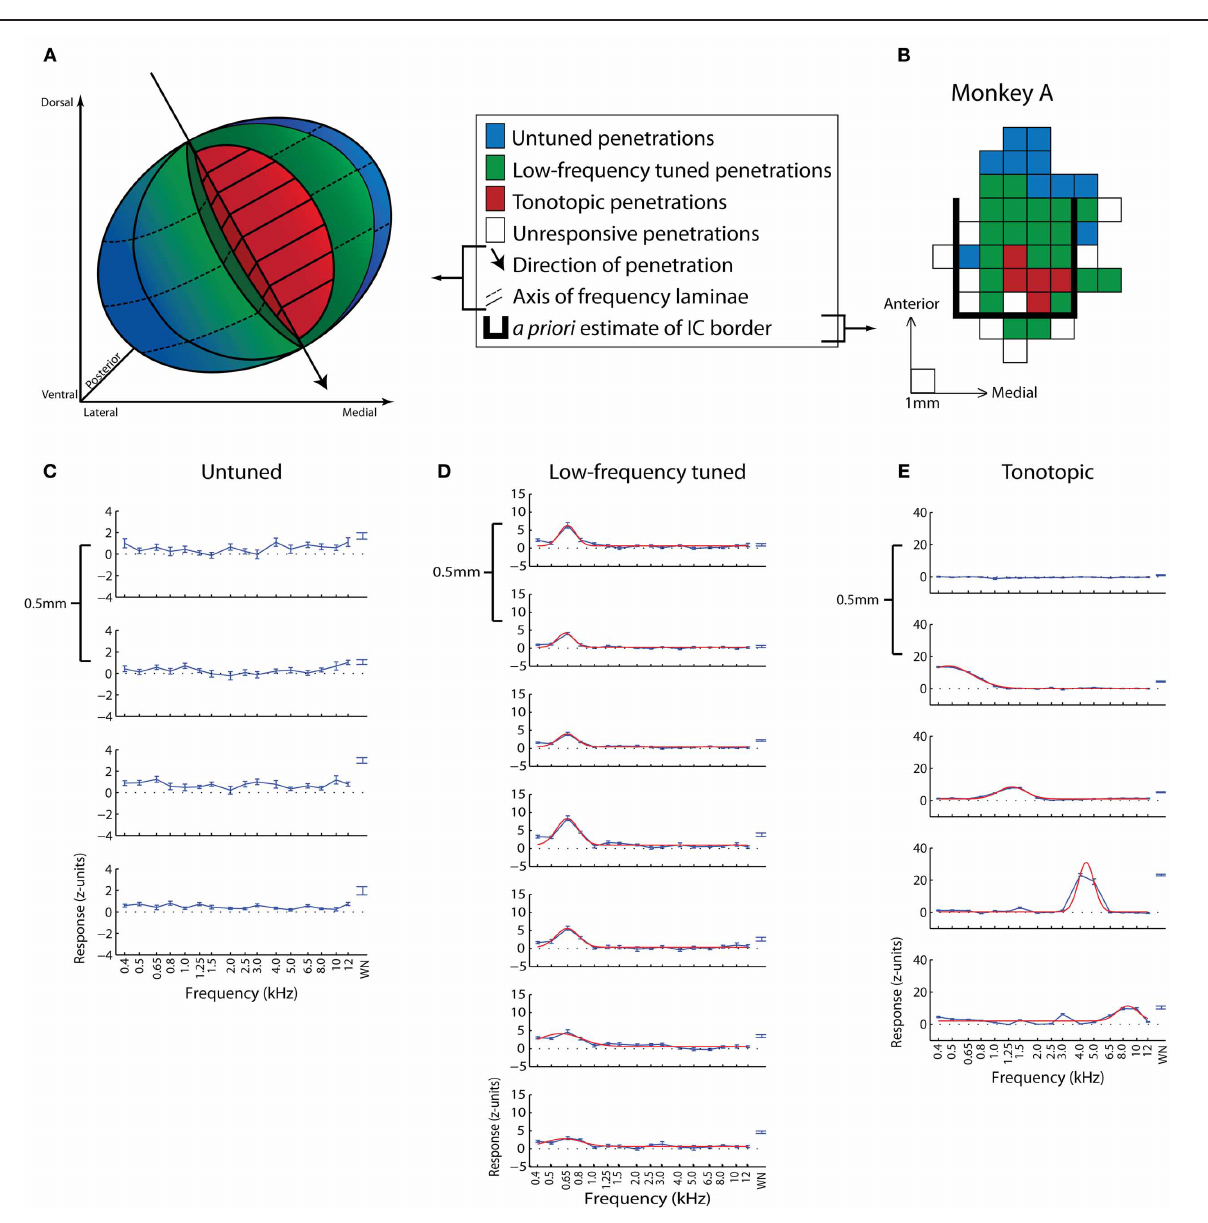
tonotopic (D) , and tonotopic (E) penetration locations. Each series is comprised of multiple recordings taken from a single example penetration. Frequency response functions were recorded at 0.5mm increments along the dorsolateral-ventromedial penetration axis. The first graph in each series corresponds to the first, i.e., most dorsal, site to show responses to auditory stimuli along that penetration. Absolute depths of first responsive sites varied across penetrations. Blue lines (C–E) indicate the normalized average response over a 200ms period as a function of sound frequency, and red lines (D,E) show the best Gaussian curve fit to tonal data. (B–E) Adapted from Bulkin and Groh (2011).